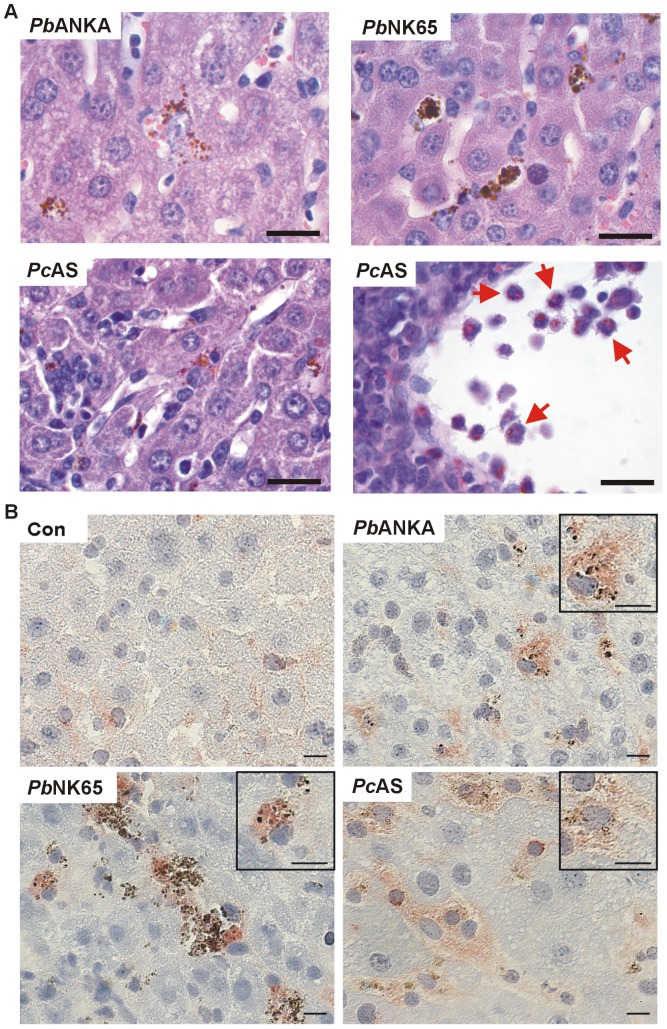
Hepatic hemozoin is localized in macrophages.(A) Higher magnification of clusters of hemozoin (Hz, brown crystals) in hematoxylin-eosin stained paraffin sections of livers from C57BL/6J mice mice infected with PbANKA (day 8), PbNK65 (day 10) or PcAS (day 10). The red arrows indicate rare Hz-containing neutrophils. Additional images are shown in Figure S2. Representative images are shown (scale bars, 20 µm). (B) Cryosections were stained with anti-F4/80 monoclonal antibodies (red color) to identify monocytes/macrophages. Insets show clusters of Hz inside F4/80+ cells. Representative images are shown (scale bars, 10 µm).